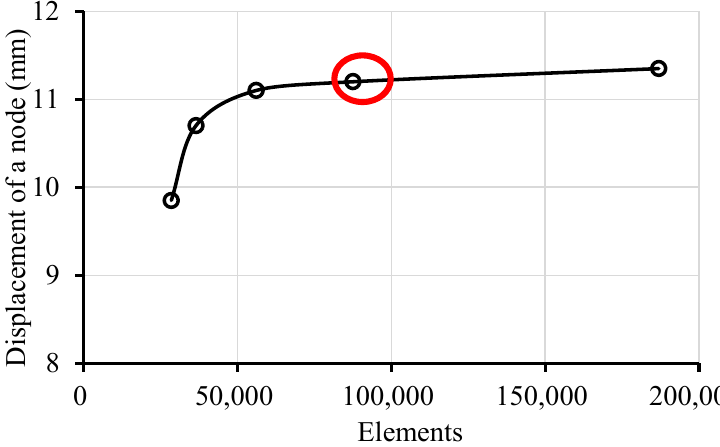
Figure 3. Mesh convergence of the h-refinement method.